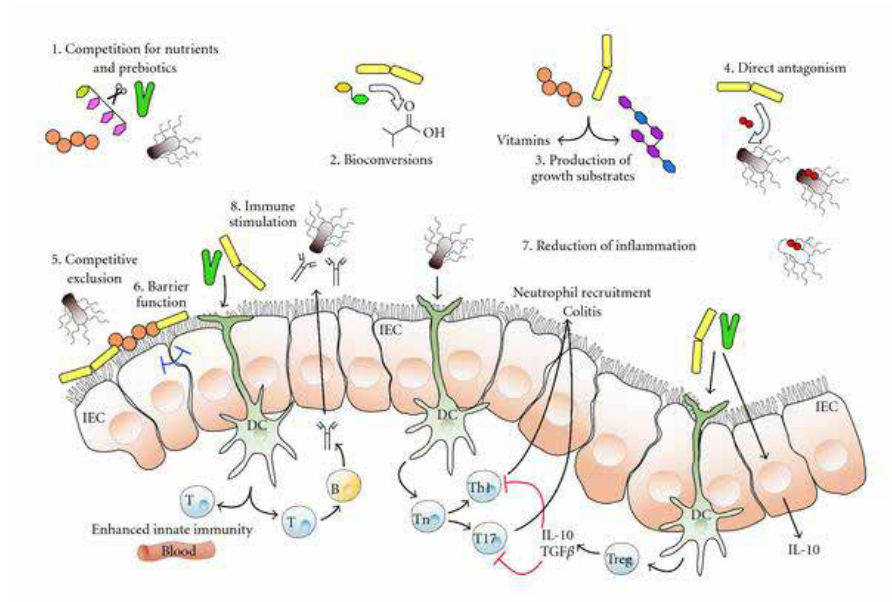
Figure 2: Schematic diagram illustrating potential or known mechanisms whereby probiotic bacteria might impact on the microbiota. These mechanisms include (1) competition for dietary ingredients as growth substrates, (2) bioconversion of, for example, sugars into fermentation products with inhibitory properties, (3) production of growth substrates, for example, EPS or vitamins, for other bacteria, (4) direct antagonism by bacteriocins, (5) competitive exclusion for binding sites, (6) improved barrier function, (7) reduction of inflammation, thus altering intestinal properties for colonization and persistence within, and (8) stimulation of innate immune response (by unknown mechanisms). IEC: epithelial cells, DC: dendritic cells,